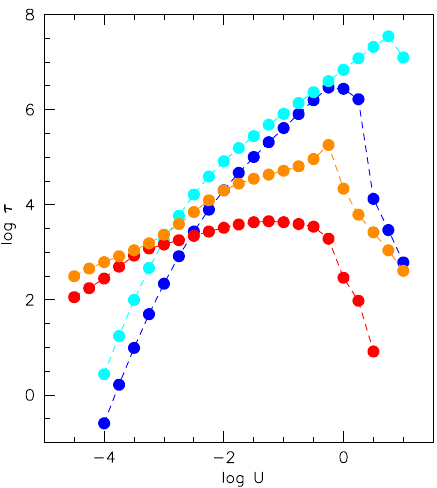
Figure 7. Line optical depth τ of C IV (blue and cyan) and Al III (red and orange) as a function of the ionization parameter U , for Z = 1 Z (cid:12) (blue and red) and 20 Z (cid:12) (cyan and orange), assuming log n H = 9 cm − 3